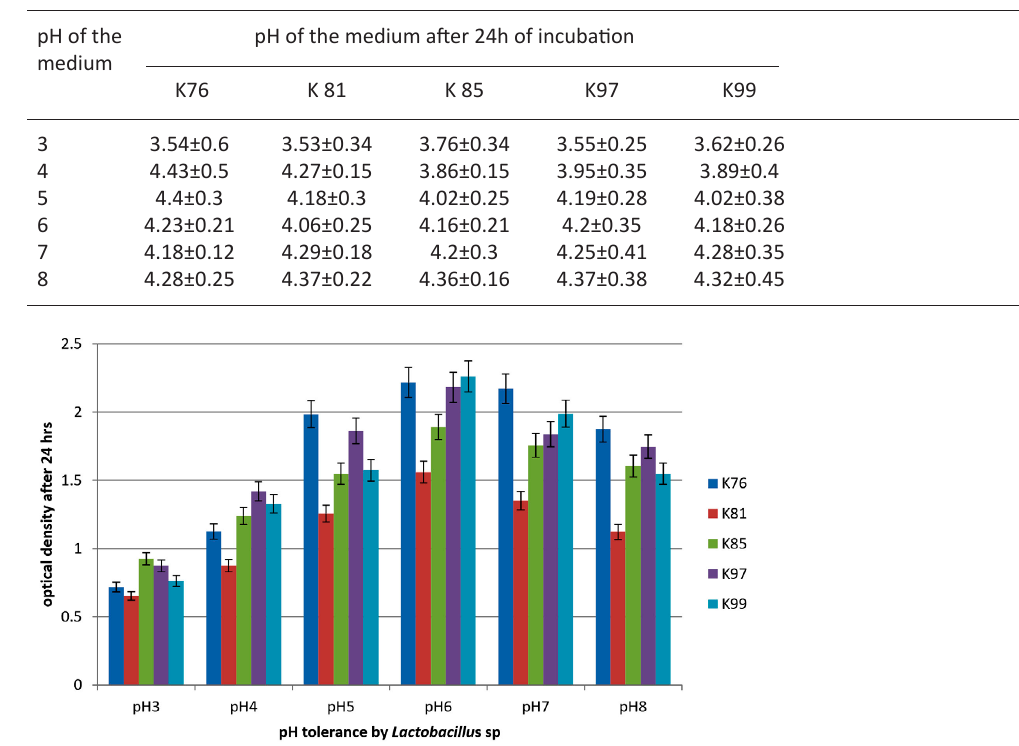
Table 1. pH tolerance of Lactobacillus mucosae (K76), L. fermentum (K81), L. fermentum (K85), L. reuteri (K97) and L. reuteri K99) to different pH. Error bars indicate ± standard deviation